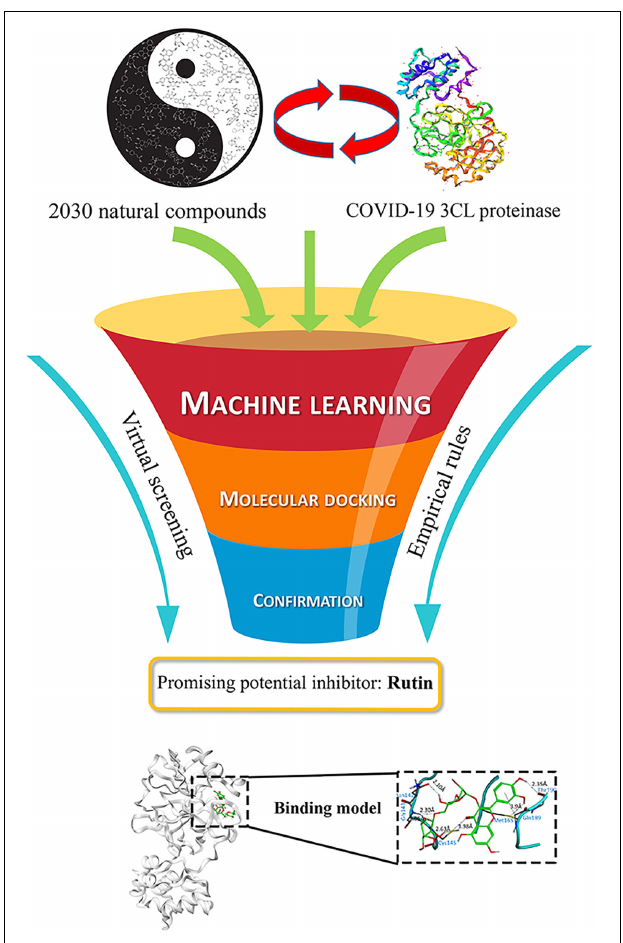
FIGURE 1 | Schematic illustration of the anti-COVID-19 discover procedure of virtual